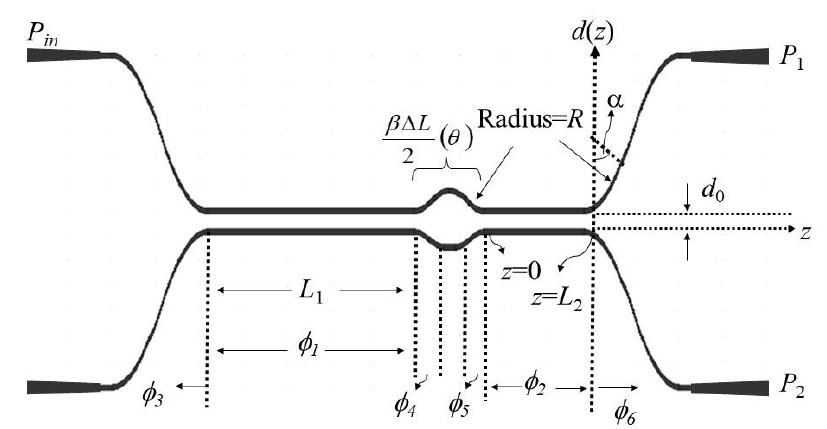
Figure 1. The schematic drawing for MZDC.